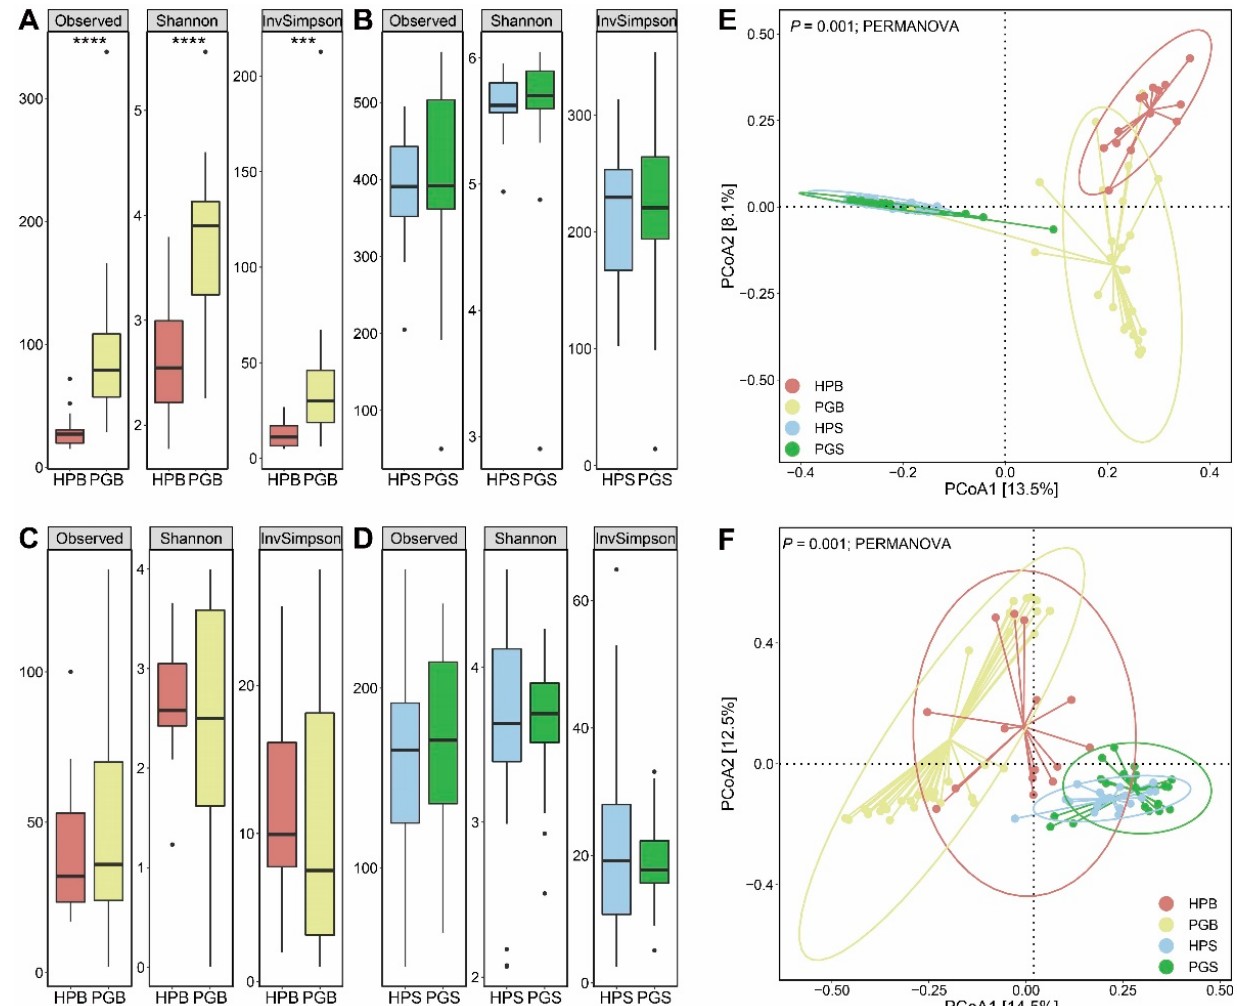
Figure 1. Biodiversity of the microbial community in soil and bark according to gummosis. The box plots of the three indexes (Observation, Shannon, and InvSimpson) represent the microbial alpha diversity values for each group. ( A ) Bacterial alpha diversity between HPB and PGB. ( B ) Bacterial alpha diversity between HPS and PGS. ( C ) Fungal alpha diversity between HPB and PGB. ( D ) Fungal alpha diversity between HPS and PGS. (Mann–Whitney, *** p < 0.001, and **** p < 0.0001). ( E , F ) Beta diversities based on Bray–Curtis dissimilarity reveal significant differences between 4 groups via PCoA. ( E ) Beta diversity of microbiome (PERMANOVA, p = 0.001). ( F ) Beta diversity of mycobiome (PERMANOVA, p =